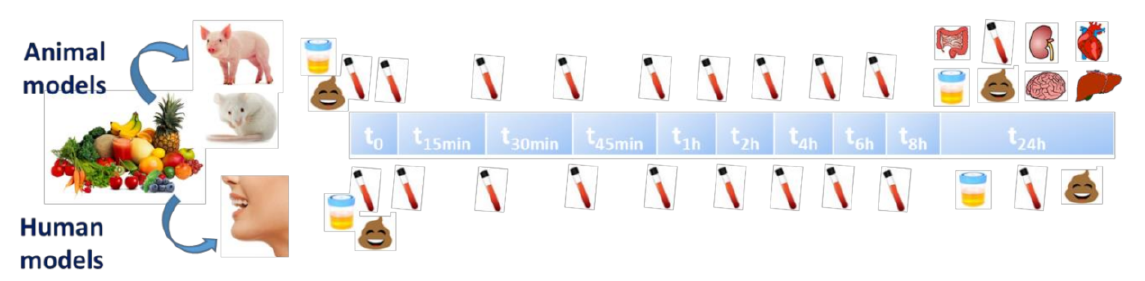
Figure 1. Scheme of a typical acute intervention study carried out in animal and human